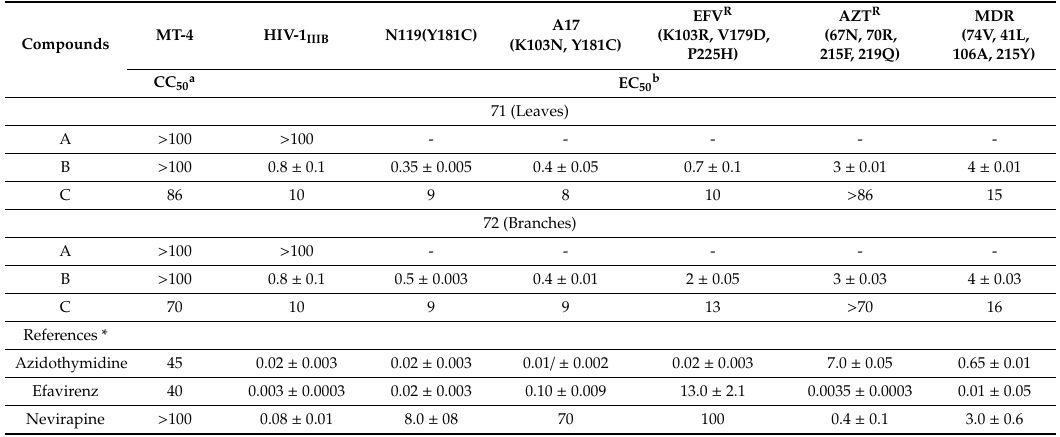
Table 2. Cytotoxicity and antiviral activity of Thymelaea hirsuta extracts, and reference compounds, against HIV-1, and its NNRTI- (N119, A17, EFV R ) and NRTI- (AZT R , MDR) resistant mutants. Compounds